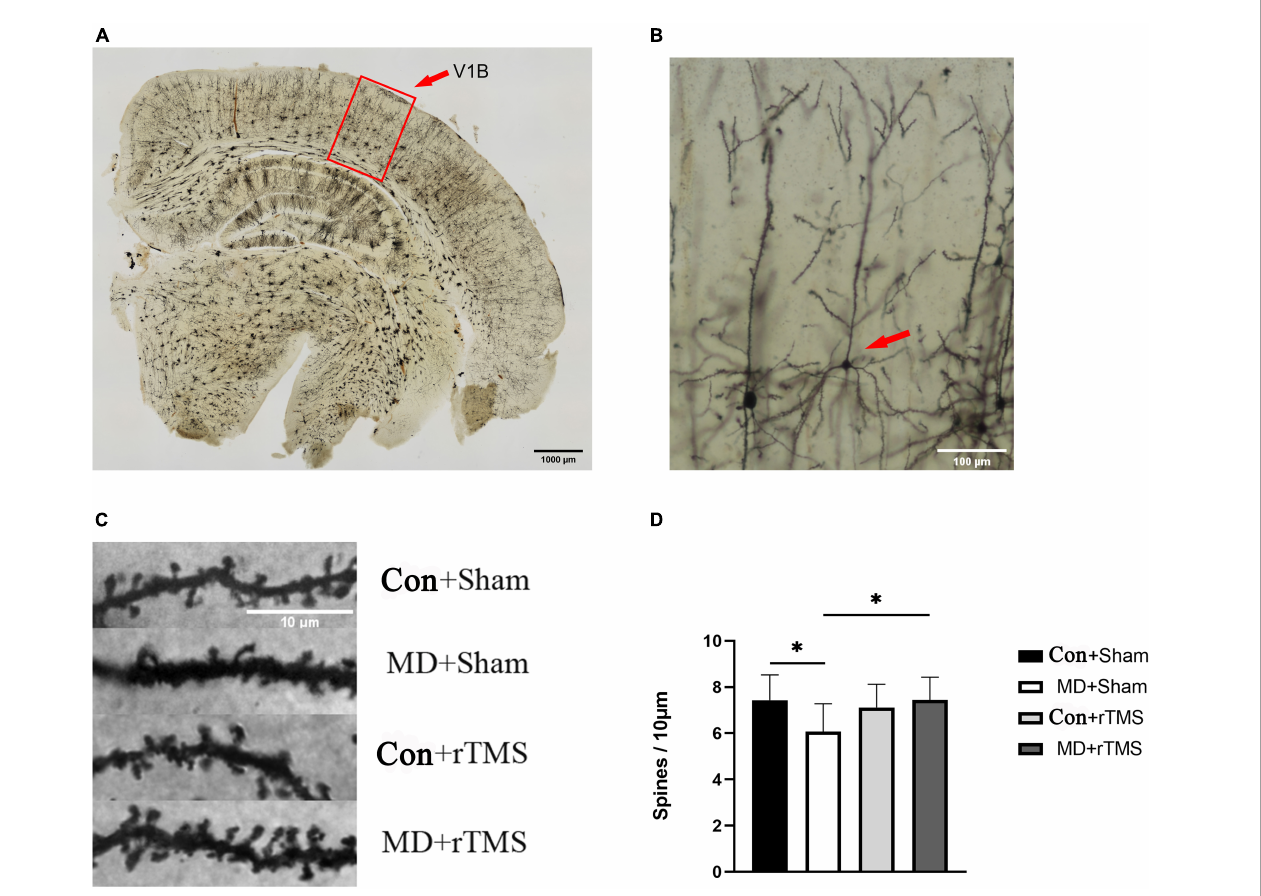
FIGURE7 Repetitive transcranial magnetic stimulation (rTMS) effectuates a significant recovery of dendritic spine density in adult amblyopic rats. (A) A representative coronal section of the occipital cortex under a low magnification microscope processed via Golgi staining. The outline (red) delineates the primary visual cortex (V1B) where dendrites were sampled; scale bar: 1,000 µ m. (B) A typical morphological pyramidal neuron in the visual cortex is pointed by the red arrow, scale bar: 100 µ m. (C) Representative dendritic segments from V1B of all four groups. A marked decrease reduction in the dendritic spine density in adult monocular deprivation (MD) rats receiving sham stimulation and an increase in spine density after rTMS; scale bar: 10 µ m. (D) Quantitative data from all the four groups were assessed by two-way analysis of variance (ANOVA). The dendritic spine density in the